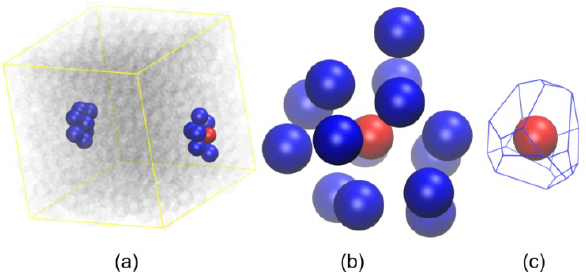
Figure 8. Illustration of the procedure adopted for the construction of the Voronoi polyhedron around a reference site. In the specific example a sphere site is randomly selected from a system configuration obtained from MC simulations on N = 12 chain system at φ = 0.56. ( a ) Reference sphere and corresponding nearest neighbors, as calculated from Voronoi tessellation, are shown in red and blue colors, respectively; sphere coordinates are subjected to periodic boundary conditions. All remaining spheres are transparent for visualization purposes. ( b ) Reference sphere and nearest Voronoi neighbors with coordinates fully unwrapped in space and sphere radii reduced for clarity.